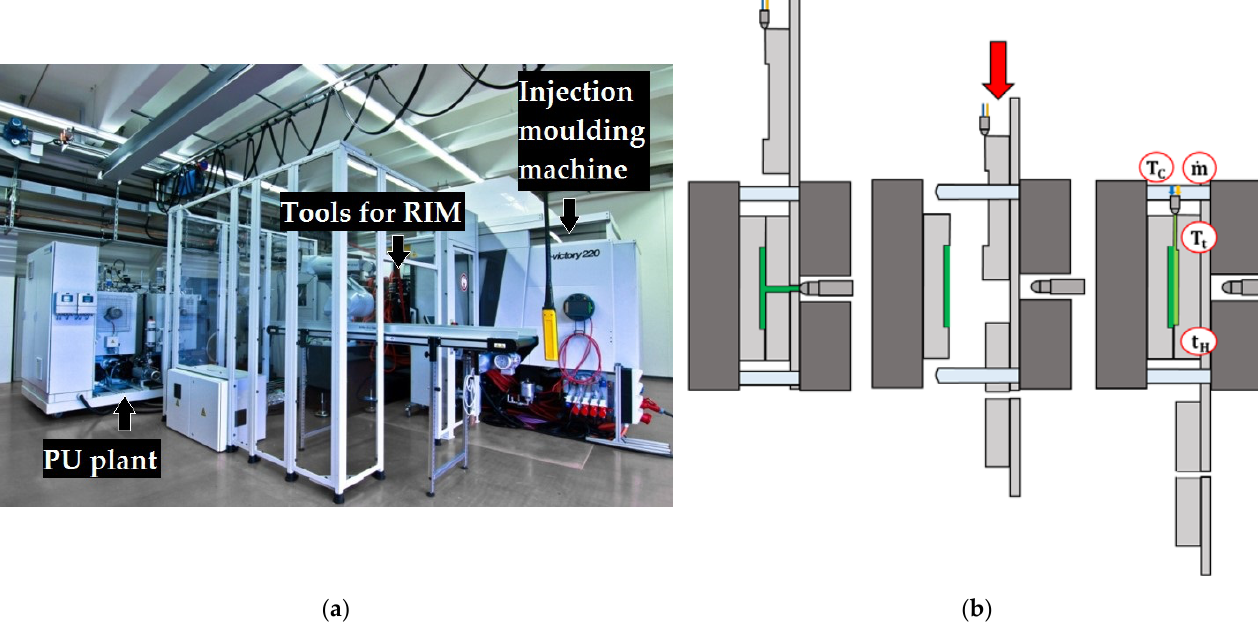
Figure 1. Manufacturing overview; ( a ) manufacturing plant at KOSTAL Automobil Elektrik GmbH & Co. KG (Lüdenscheid, Germany); ( b ) scheme of the RIM tooling. Specimens for the DMTA and tensile test are milled out from the polyurethane plates.